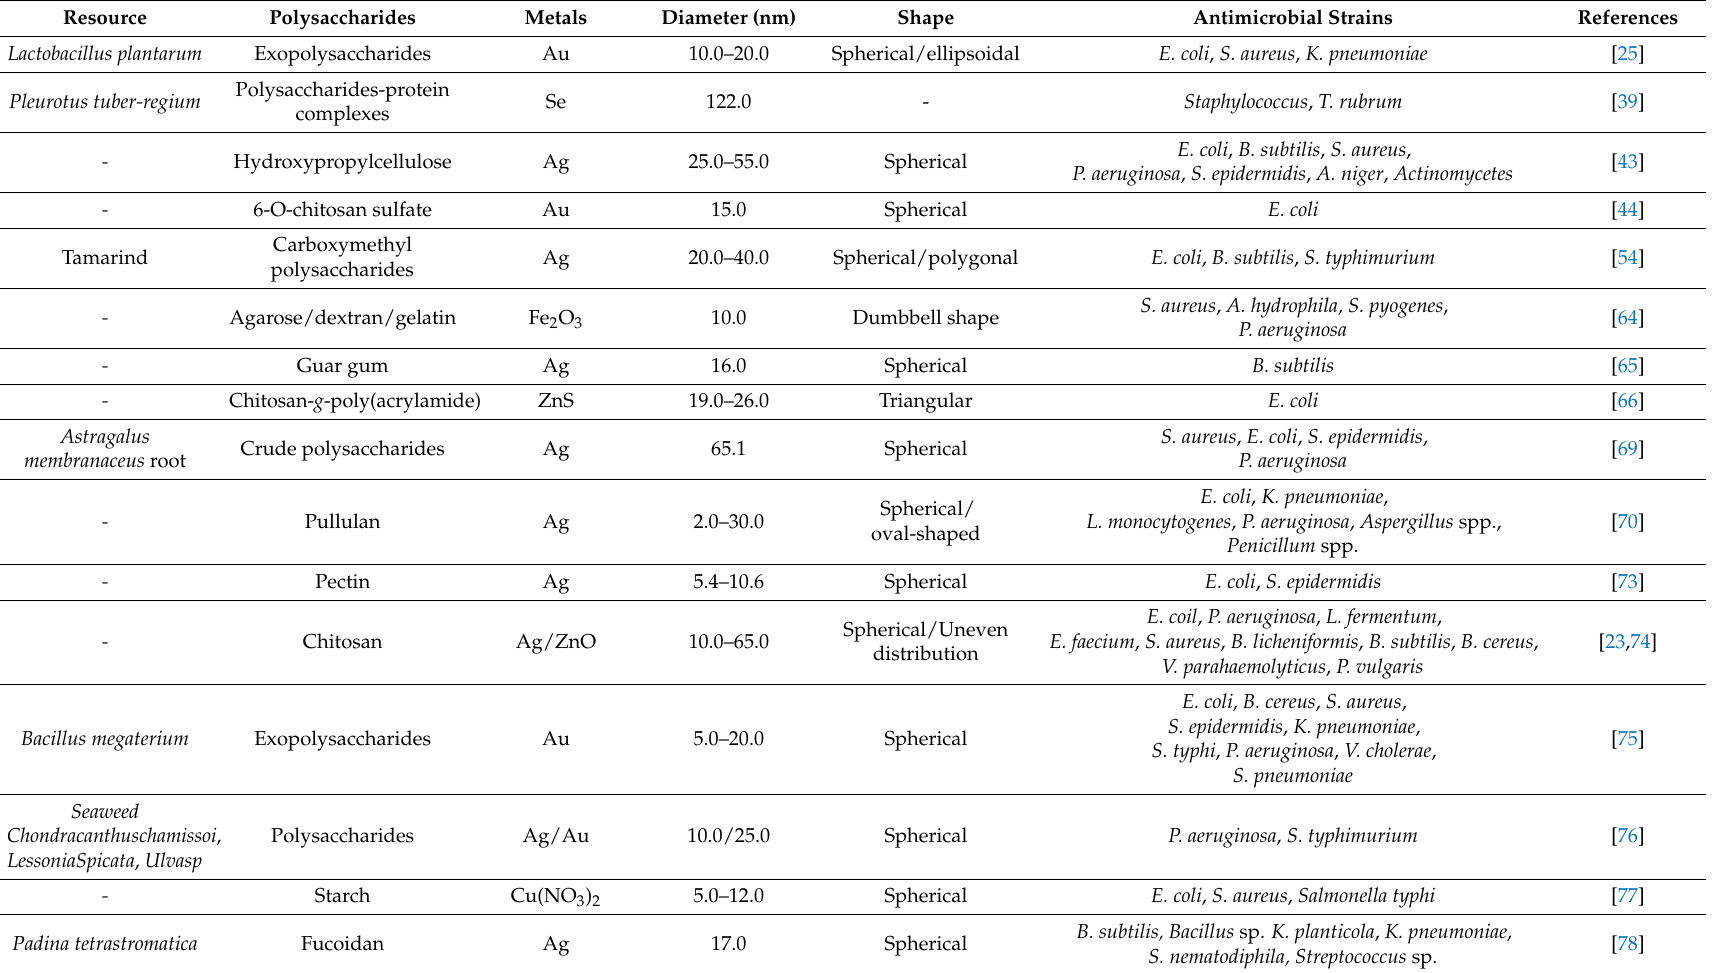
Table 1. Summary of literature data regarding the antimicrobial property of